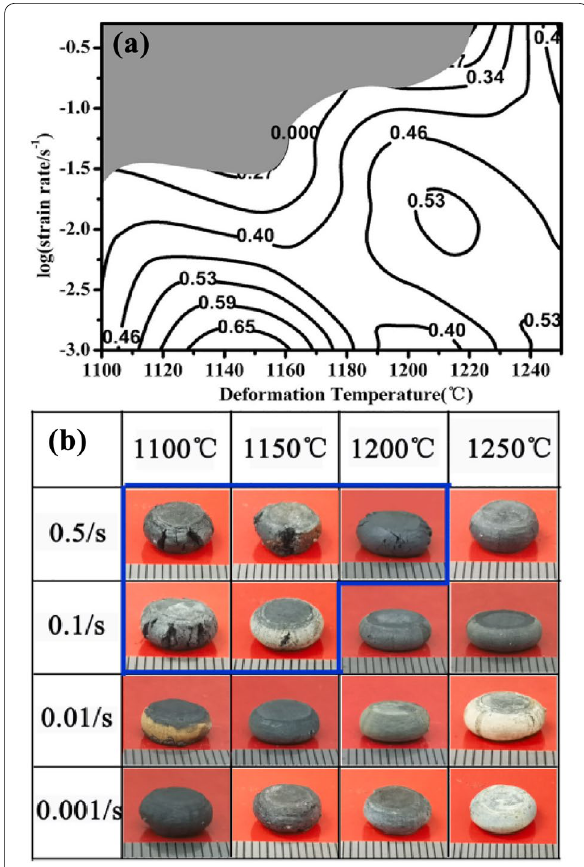
Figure 18 Processing map and macro-morphologies of compressive specimens for MoNbHfZrTi RHEA [89] ( a ) processing map where the grey part is the instability zone, ( b ) cracking situation at different hot deformation parameters where instability zone is in